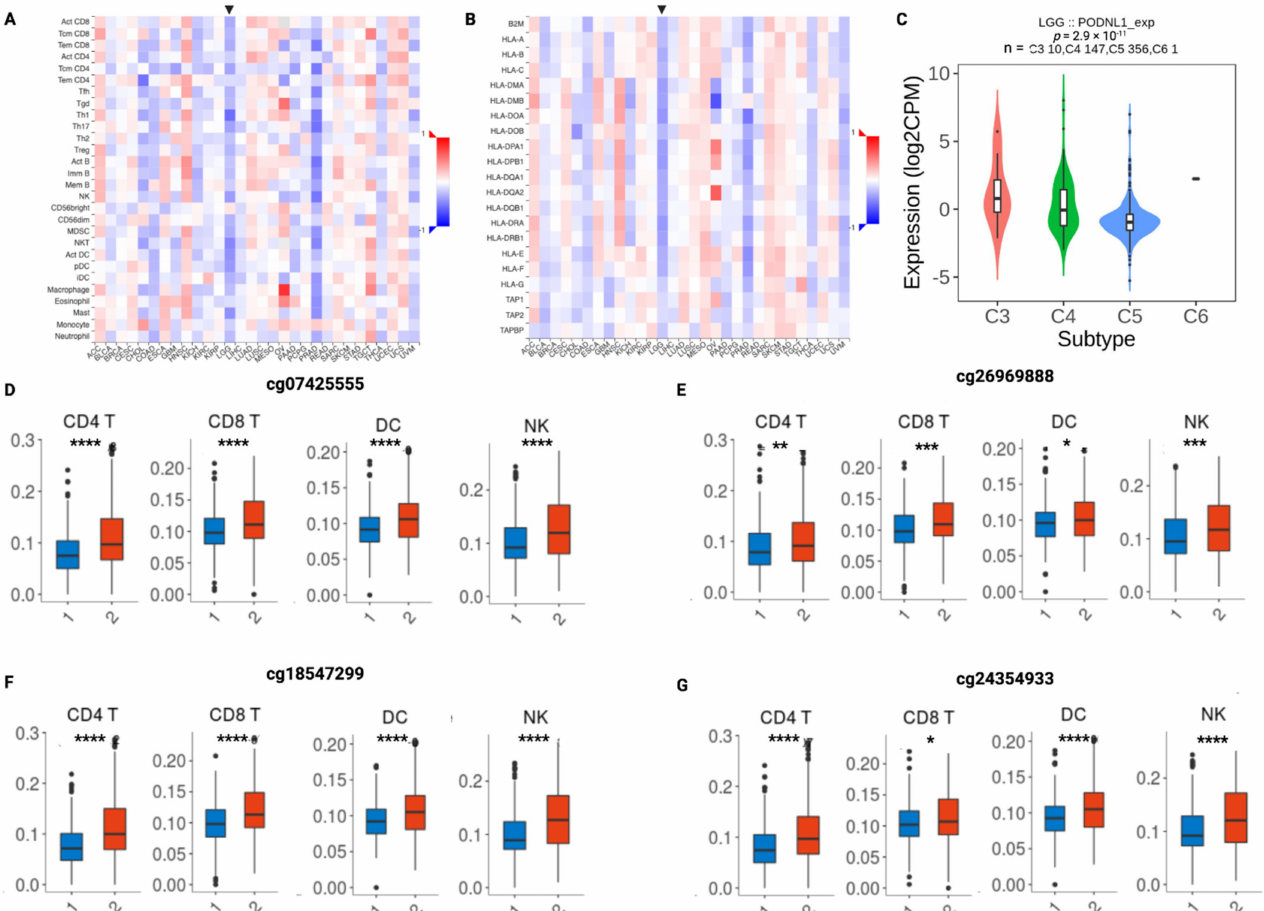
Figure 6. Association of PODNL1 methylation and expression, with immune cell infiltration and immune subtypes. Correlation heatmap between PODNL1 methylation (beta values) and ( A ) immune infiltrates and ( B ) MHC class II molecules across TCGA cancers (LGG marked with a black arrow; analyzed using TISIDB). ( C ) PODNL1 mRNA expression levels in TCGA-LGG immune subtypes. C3: inflammatory ( n = 10), C4: lymphocyte depleted ( n = 147), C5: immunologically quiet ( n = 356), C6: TGF-b dominant ( n = 1). One-way ANOVA p -value = 2.9 × 10 − 11 . ( D – G ) Association between specific PODNL1 CpG methylation group (group 1 = high methylation and group 2 = low methylation; stratified by median beta value cut-off) infiltrating immune cells in all four significant CpGs. Statistical significance was determined by a Student’s t-test with a p -value < 0.05. **** p < 0.0001, *** p < 0.001, ** p < 0.01, and * p <